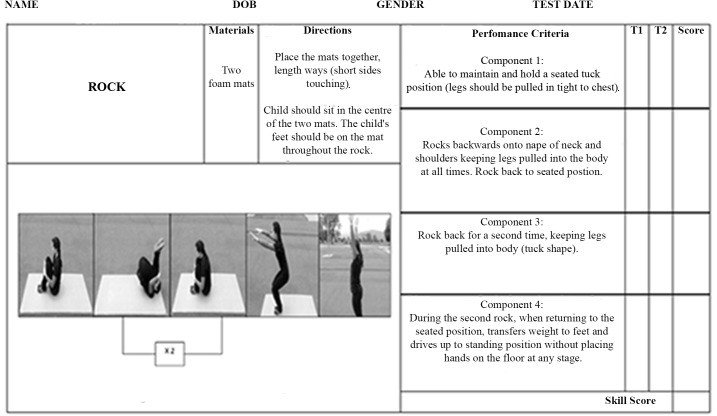
Rock scoresheet.